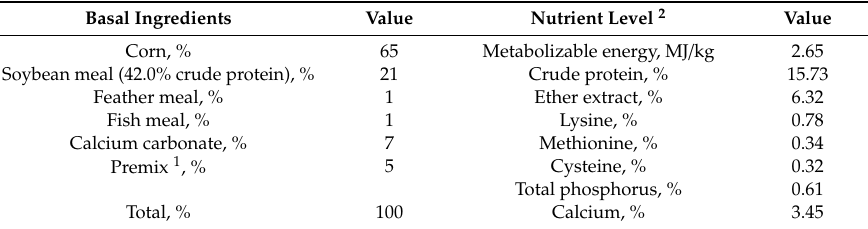
Table 1. Ingredient compositions and nutrient levels of basal diet for